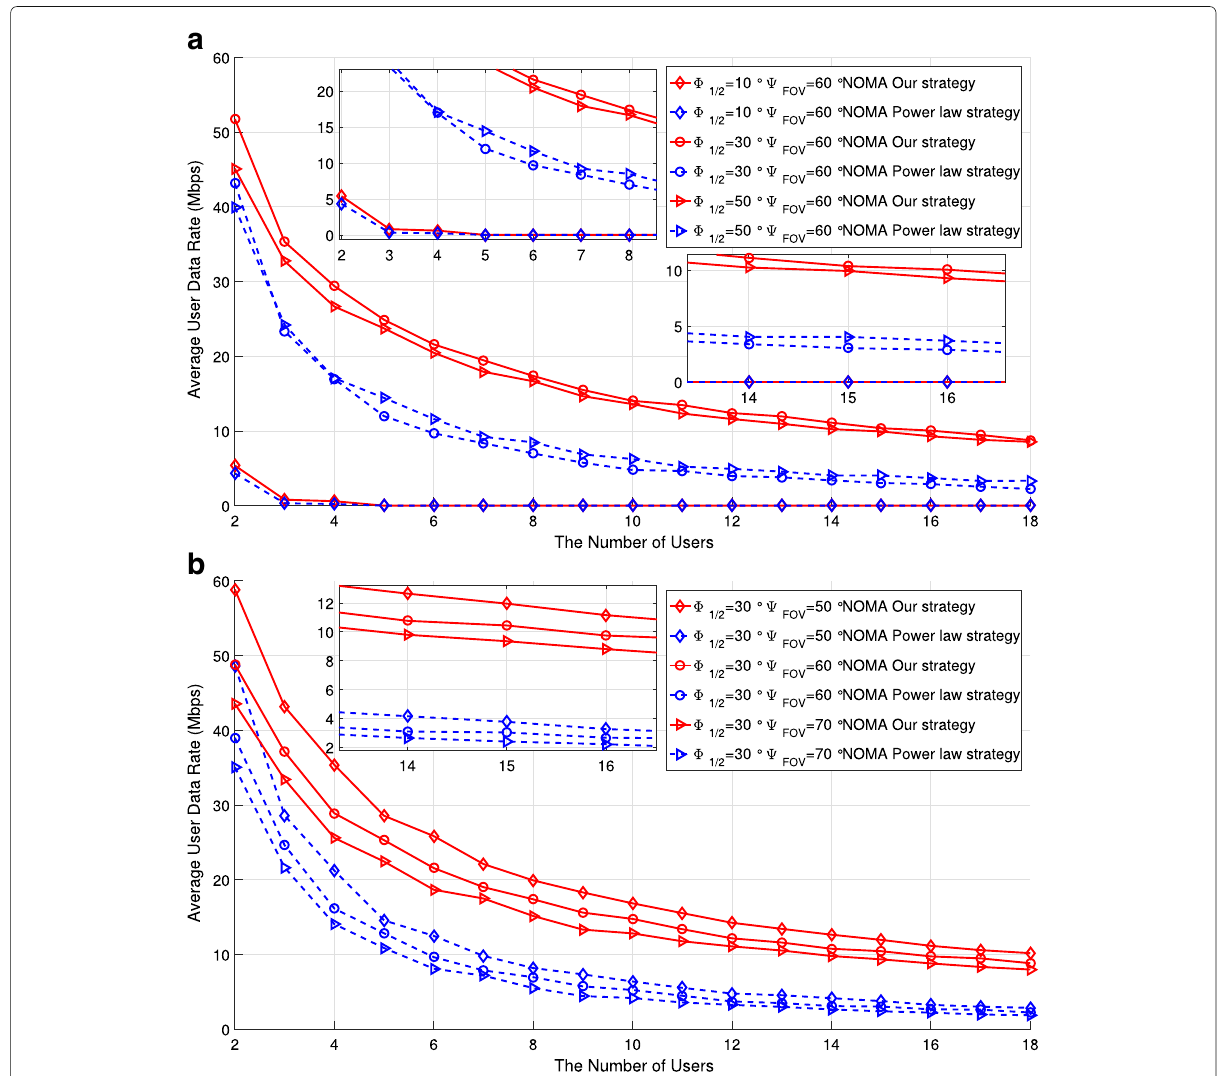
Fig. 5 The AUDR comparison between our strategy and power law strategy with an increasing number of users. a Comparison of NOMA-VLC GRPA strategies with fixed (cid:6) FOV . b Comparison of NOMA-VLC GRPA strategies with fixed (cid:5) 1 /